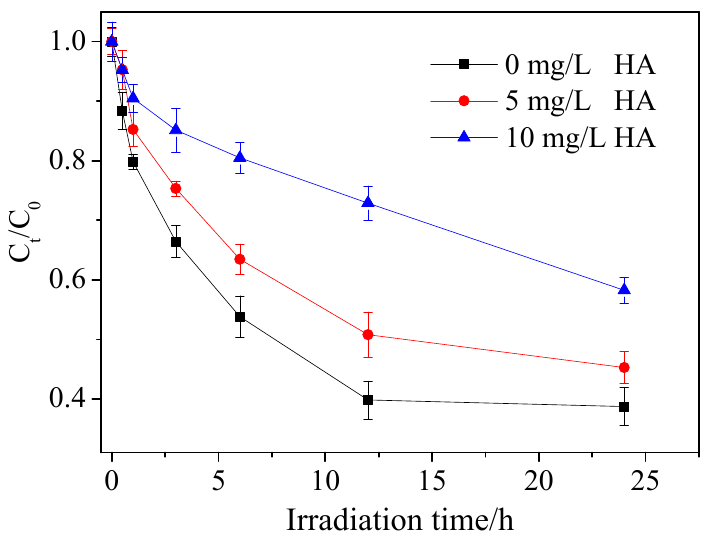
Table 5. BDE-209 photodegradation kinetic parameters with different concentrations of HA.